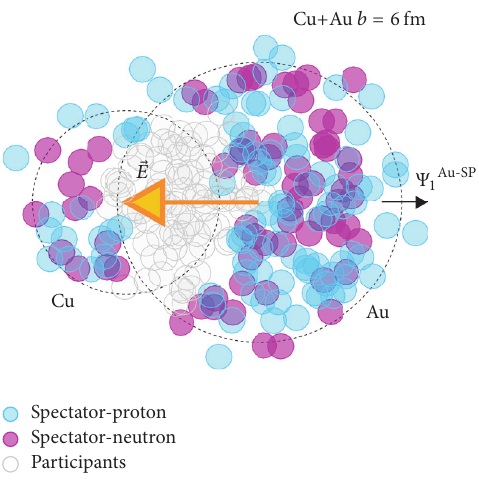
Figure 2: Example of a noncentral Cu+Au collision viewed in the transverse plane showing an initial electric field charge difference between the two nuclei [27]. Ψ 1 Au-SP denotes the direction of Au